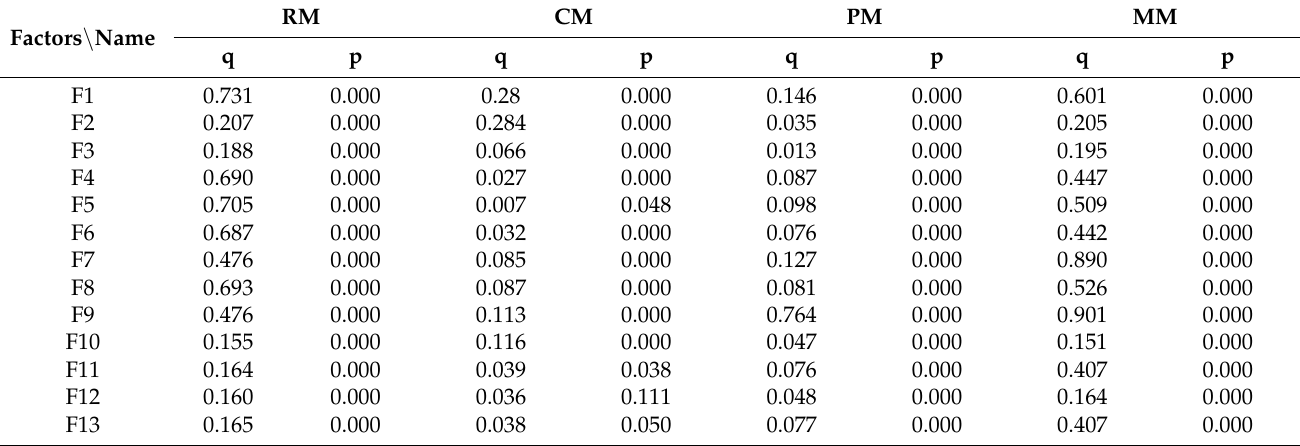
Table A6. Data for factors (q and p) controlling change in areas for different types of